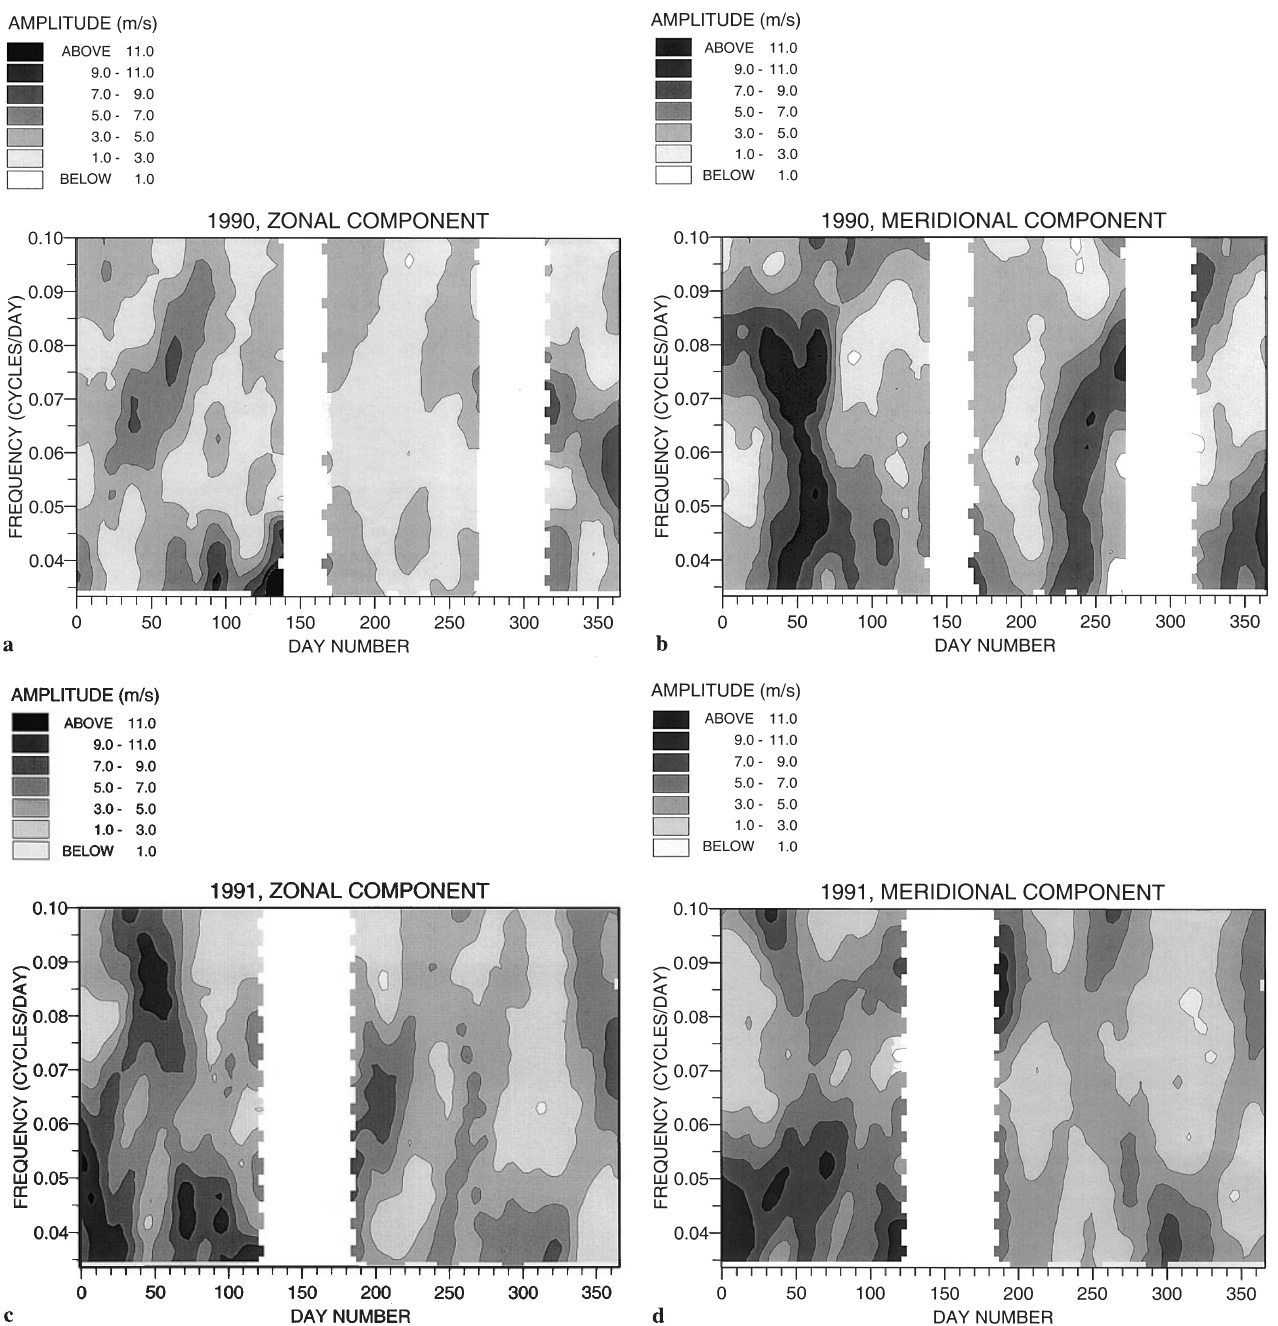
Fig. 2a–j. Spectrograms of zonal and meridional wind amplitudes as a function of frequency and time for 1990: a, b ; 1991: c, d ; 1992: e, f ; 1993: g, h ; 1994: i,